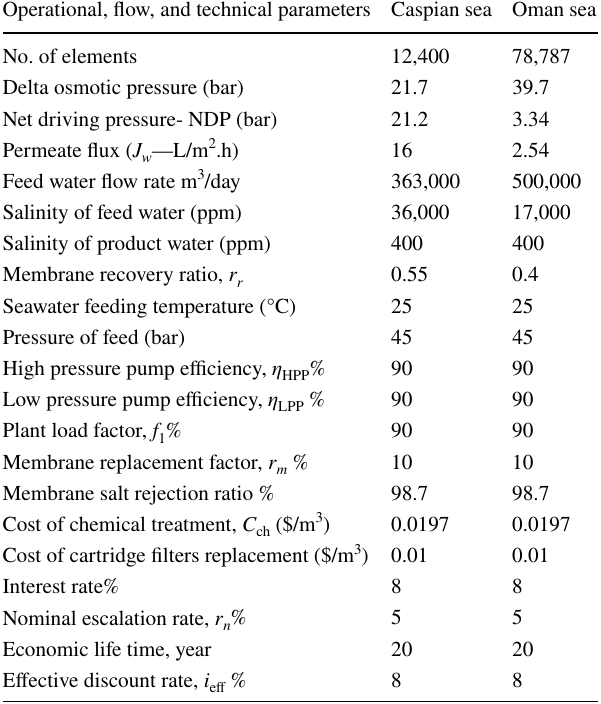
Table 2 Parameters of conceptual RO desalination plant with capac- ity of 200,000 m 3 /day for two different intake water of Caspian and Oman sea (using membrane element DOW filmtec SW30HRLE) Operational, flow, and technical parameters Caspian sea Oman sea